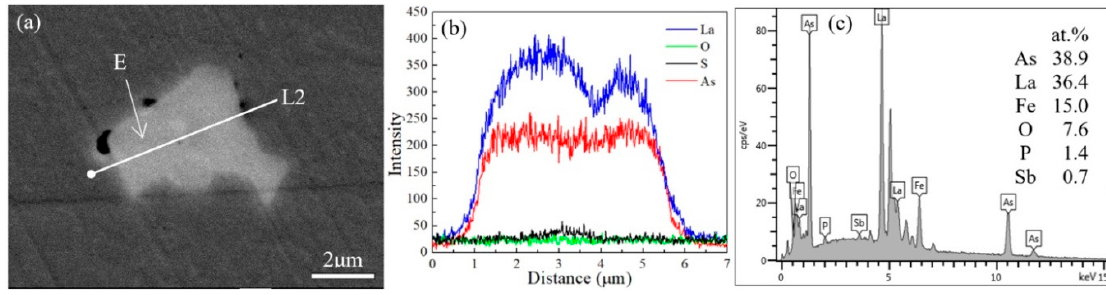
Figure 5. Morphologies and chemical compositions of La-As inclusions. ( a ) Morphologies of inclusions; ( b ) line scanning of position L2; ( c ) EDS of position E.